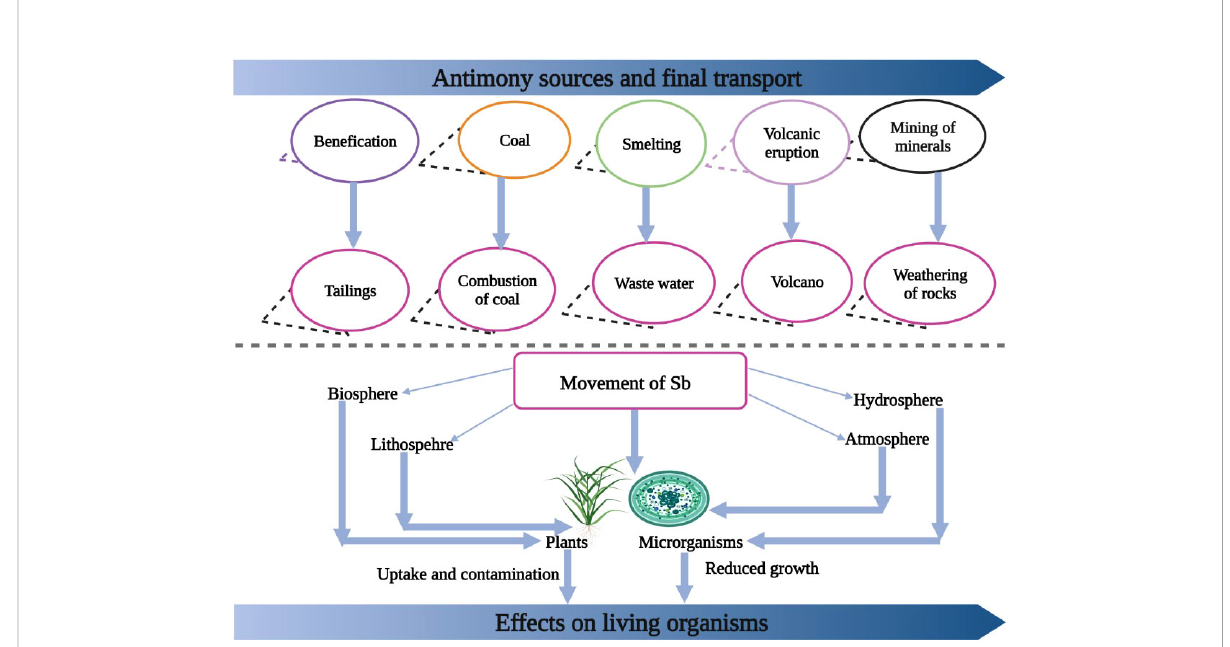
FIGURE 1 The various sources of Sb entry into environment. Sb enters into environment from burning of coal, smelting, volcanic eruptions and mining of minerals. After entering into environment it cause toxic effects to plants and